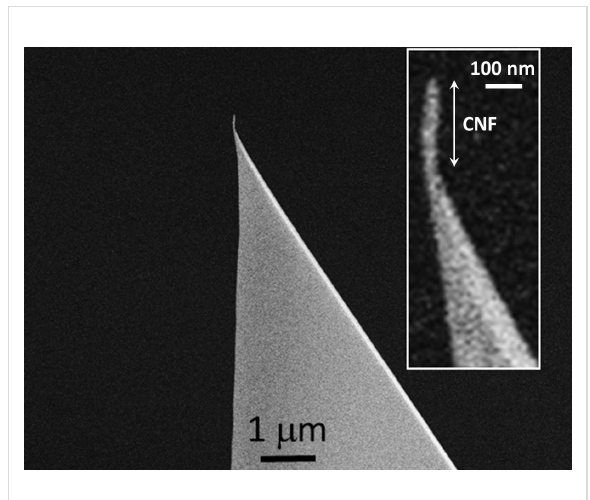
Figure 1: SEM image of a typical example of an as-deposited CNF onto the tip apex of the Si AFM probe.